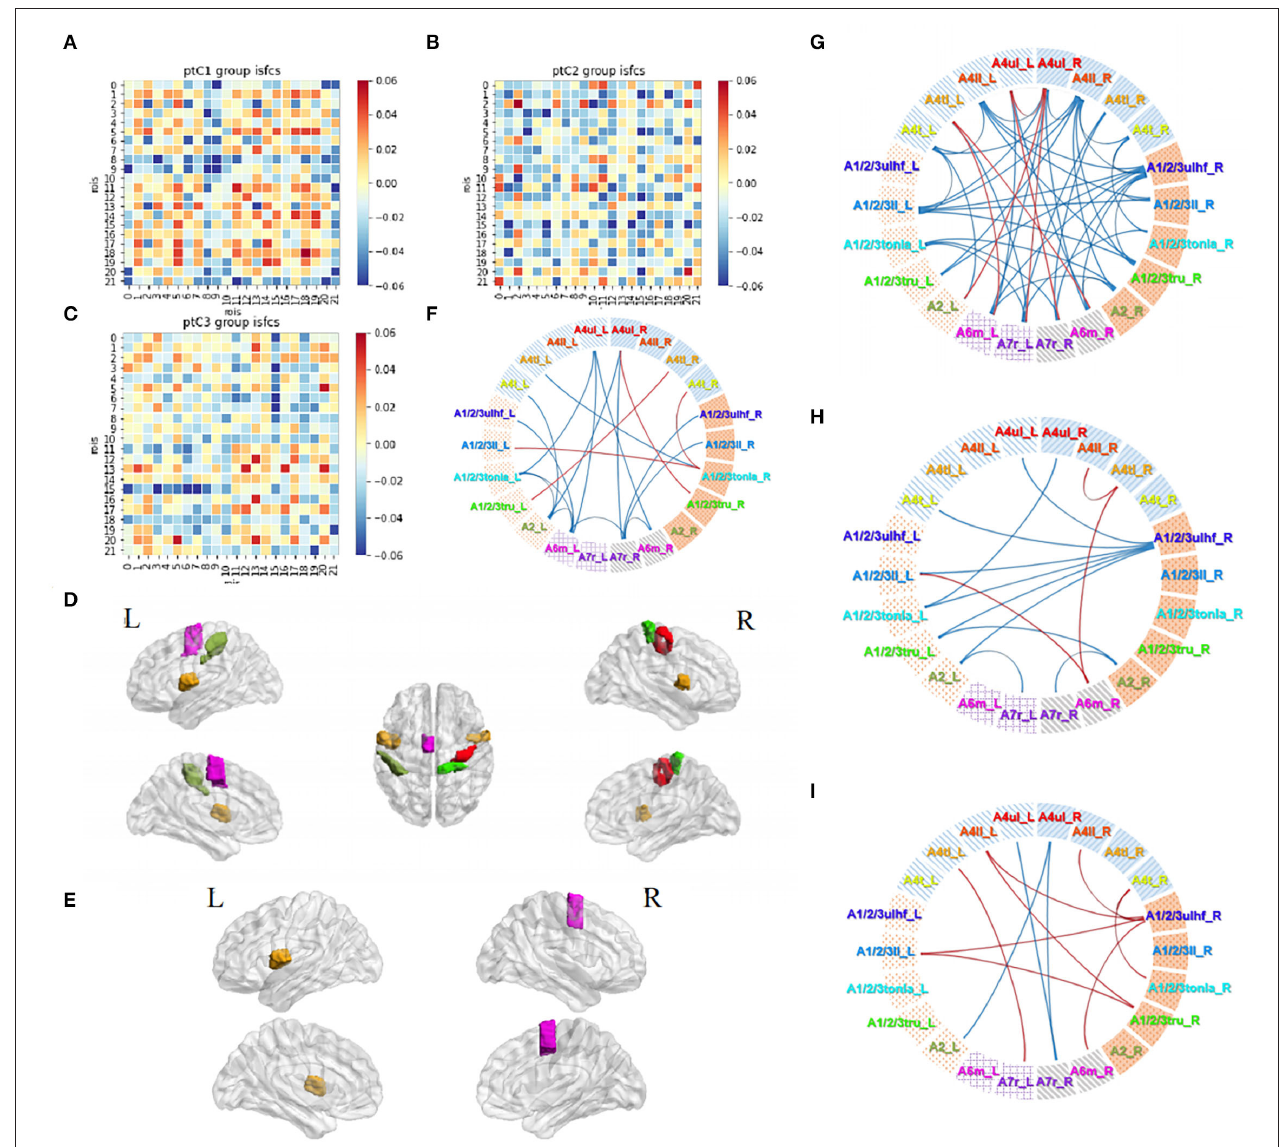
FIGURE 7 | Acupuncture task-stimulated ISC and ISFC in subgroup Cs. (A–C) ISFC matrix of 22 ROIs in C1, C2, C3. (D,E) Significantly stimulated ROIs in C1, C2 ( p < 0.05, FDR-corrected). (F–H) Significant ISFCs between ROIs in C1, C2, C3 group ( p < 0.05, FDR-corrected). (I) Significant ISFCs between C1 vs. C2 ( p < 0.05,